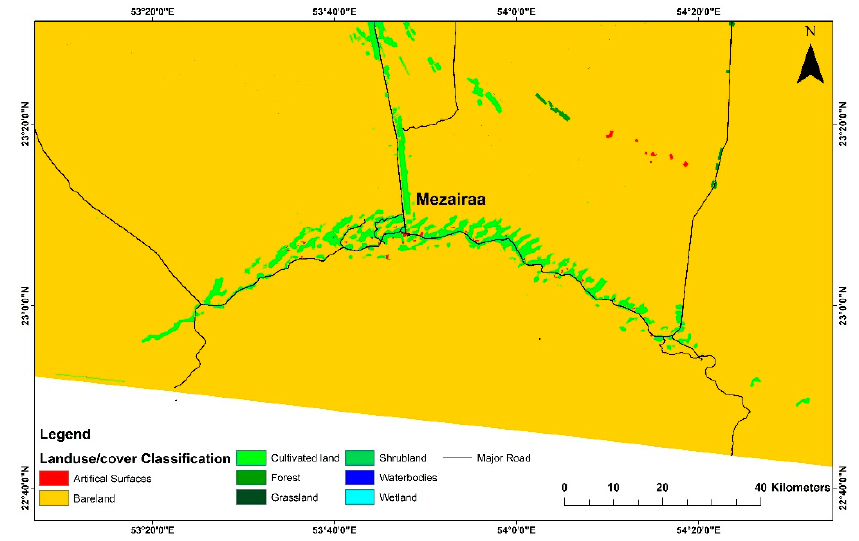
Figure 2. Land use/cover distribution map of the study area, Liwa, Abu Dhabi.